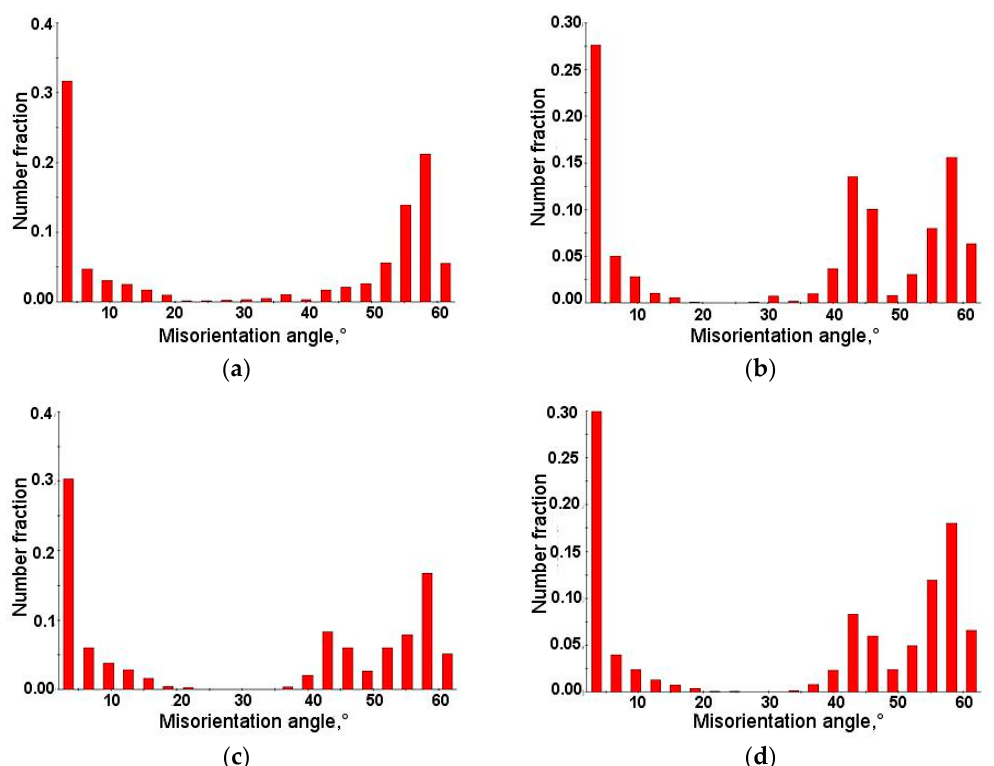
Figure 11. Distribution of misorientation angles in the specimens deformed at: 20 °C ( a ), 60 °C ( b ), 100 °C ( c ), and 200 °C ( d ).